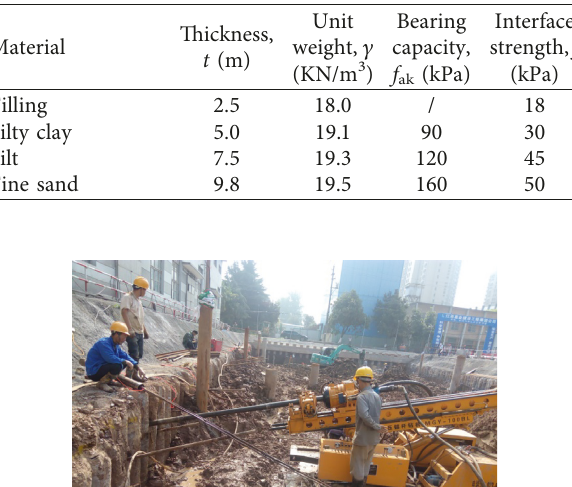
Table 2: Summary of the conducted tests.